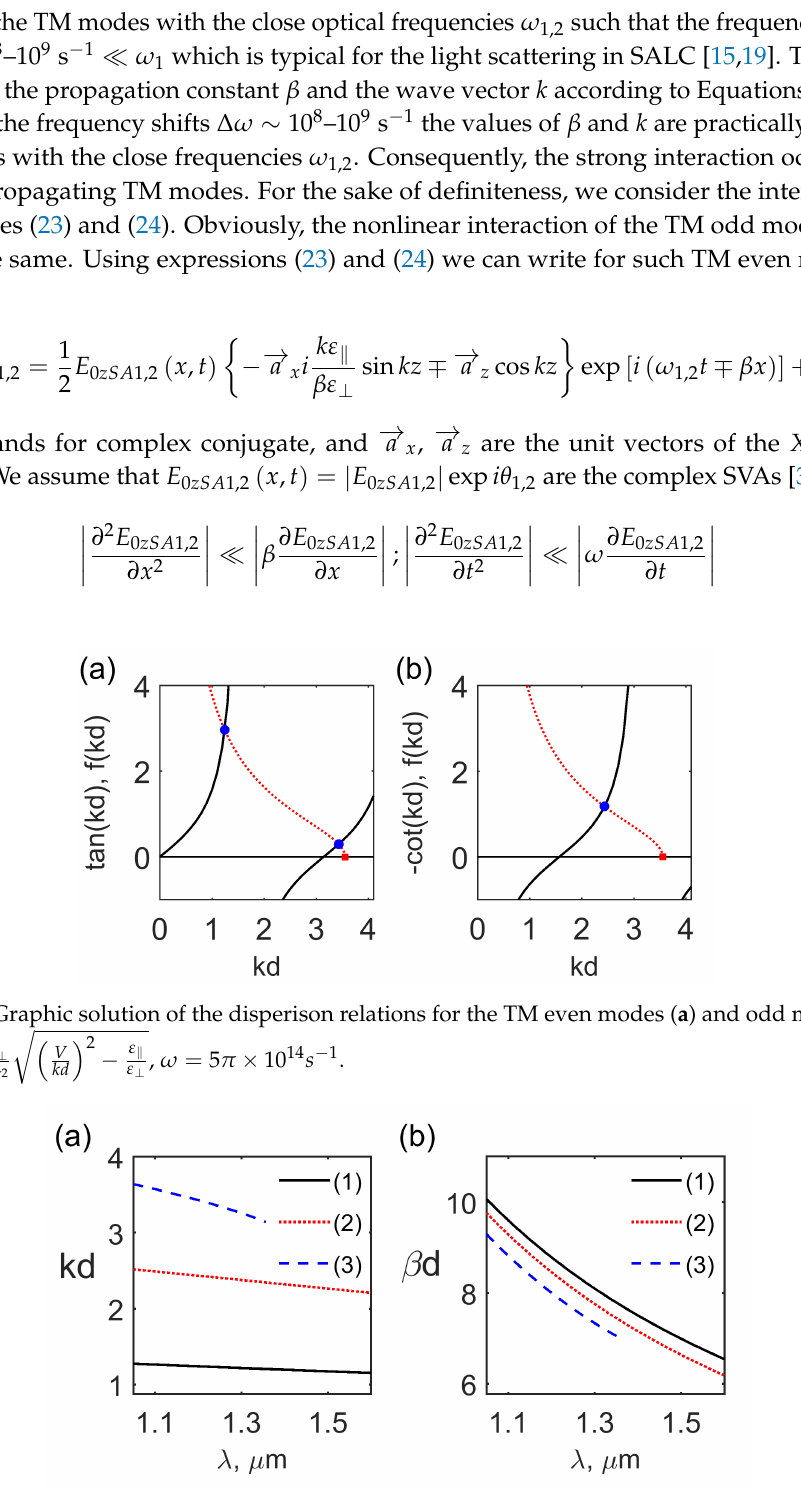
(curves 1, 3) and the odd mode TM odd 0,1